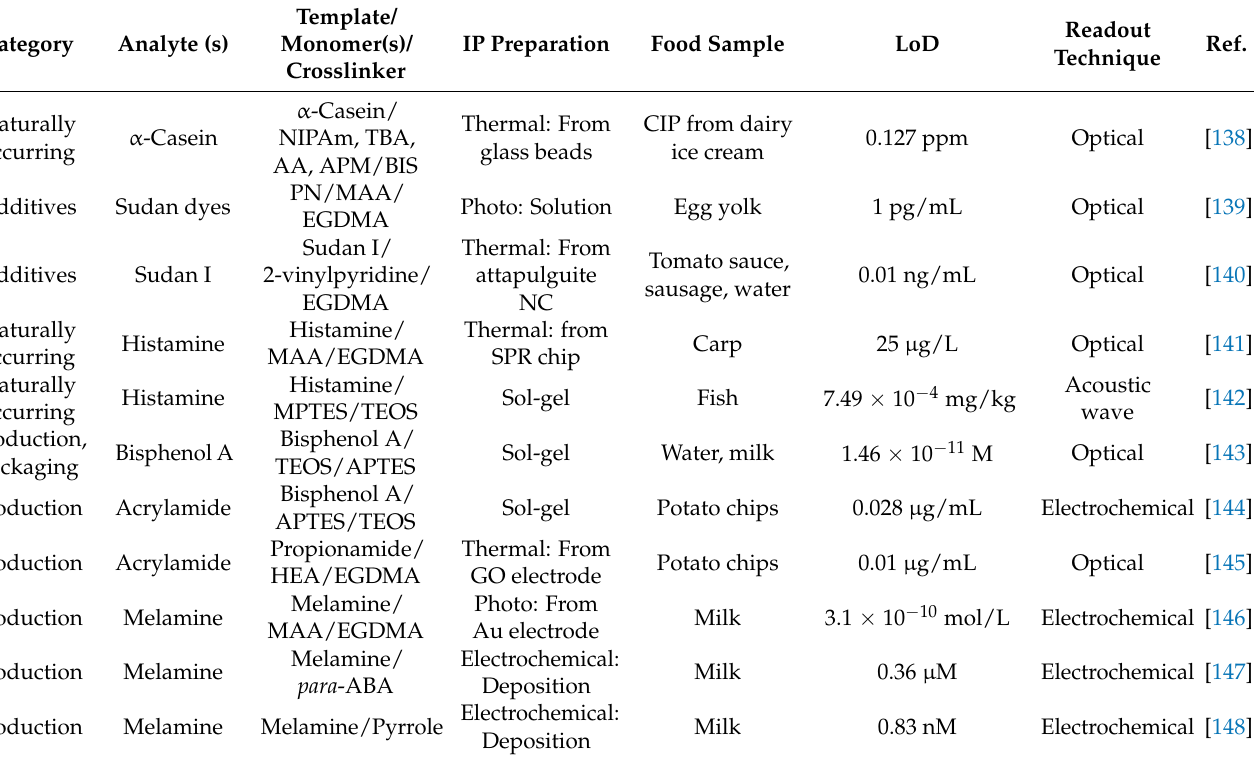
Table 3. Summary of recent publications for the recognition of other chemical contaminants using IPs in food